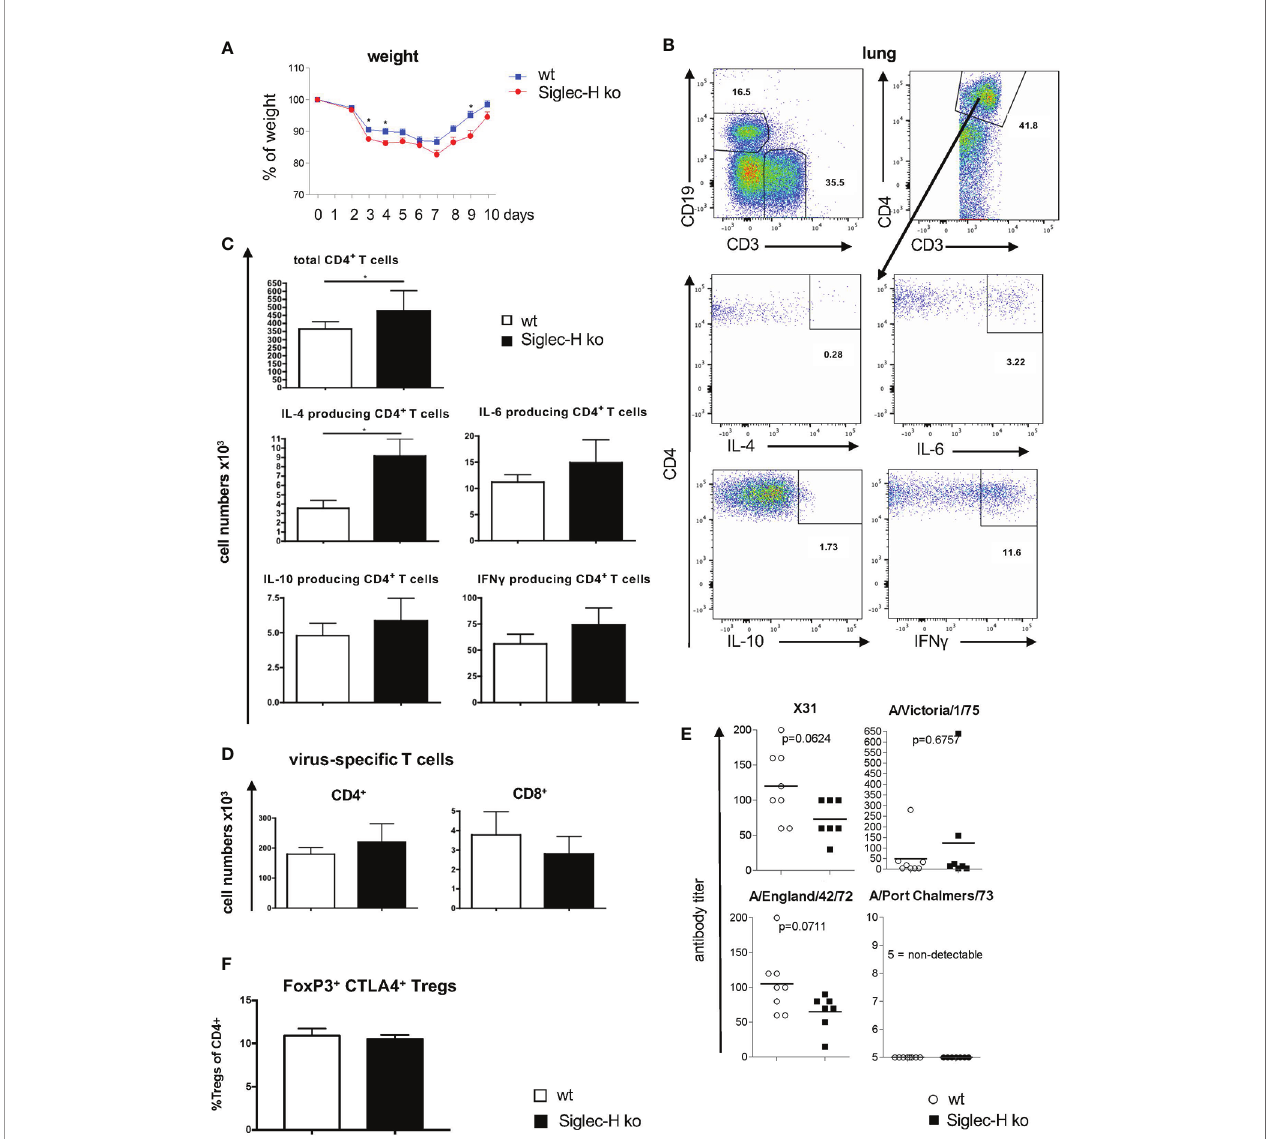
FIGURE 1 | Increased weight loss and more CD4+ T cells in lungs of Siglec-H ko mice 10 days after in fl uenza H3N2 infection. wt and Siglec-H ko mice were intranasally infected with 10 4 pfu In fl uenza H3N2 (X-31) virus. On day 10 the mice were euthanized and cell populations were analysed via fl ow cytometry. Serum was analysed on virus-speci fi c antibodies after 20w. (A) Weight loss of wt and Siglec-H ko mice over 10 days of In fl uenza infection. (B) Gating strategy for the analysis of intracellular cytokines in CD4 + T cells. Living, single lymphocytes were stained with anti-CD3 and anti-CD19 to select T and B cells. CD3 + cells were marked as T cells and subsequently divided by CD4 and CD8 expression. Intracellular cytokines IL-4, IL-6, IL-10 and IFNy were stained in CD4+ and CD8+ T cells. (C) Absolute numbers (x10 3 ) of total CD4+ T cells and IL-4, IL-6, IL-10 and IFN g ; producing CD4 T cells in lungs of wt and Siglec-H KO mice. (D) Absolute numbers (x10 3 ) virus-speci fi c CD4 and CD8 T cells analysed by fl uorescence-coupled In fl uenza peptide ASNETMN staining. (E) Serum titers of strain-speci fi c antibodies in wt and Siglec-H ko mice 20 weeks p.i. (F) Percentages of CD4+ FoxP3+ CTLA4+ Tregs in medestrial lymph nodes, 10 days after in fl uenza infection. Mice were aged between 8-14 weeks, Data from one experiment, N=10 per genotype. Mann-Whitney test, *p < 0.05. Error bars are mean ± SD